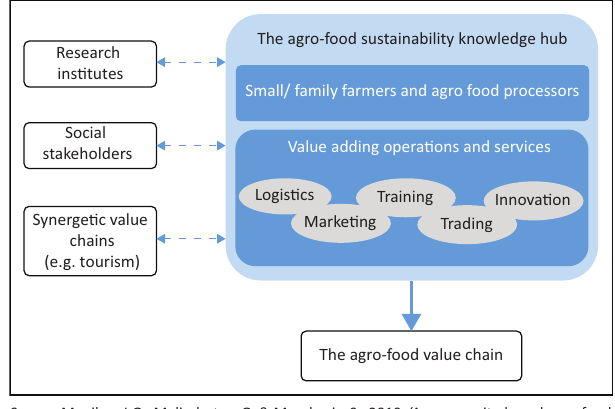
FIGURE 7: Provincial knowledge production and coordination Colab.